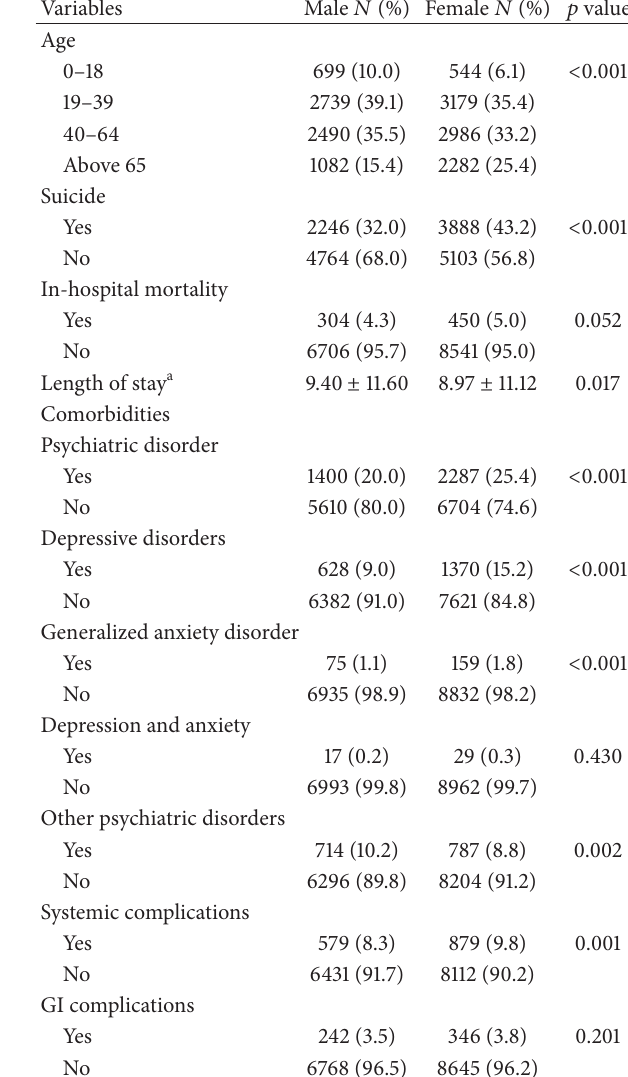
Table 3: Compare gender difference between male and female of corrosive injuries